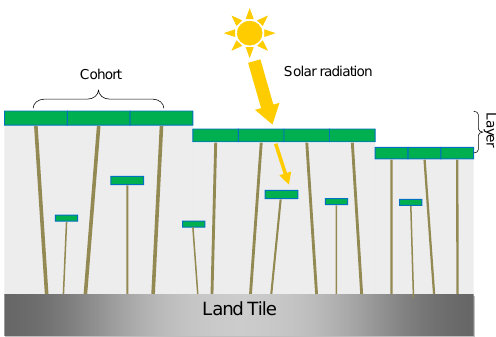
Figure A1. Cohorts and forest